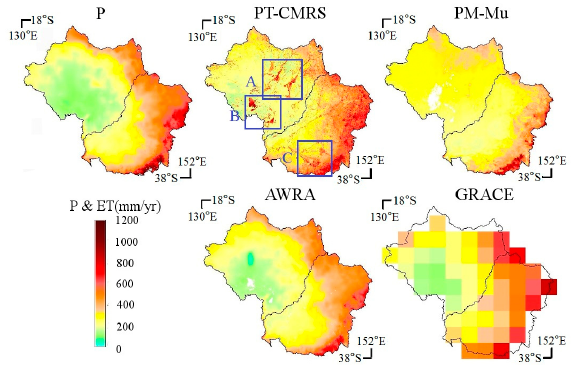
Figure 2. Spatial distribution of mean annual rainfall (P) and mean annual ET derived from PT-CMRS, PM-Mu, AWRA, and GRACE across the Murray-Darling and the Lake Eyre Basins. Boxes A, B, and C show areas that are zoomed in Figure 3.